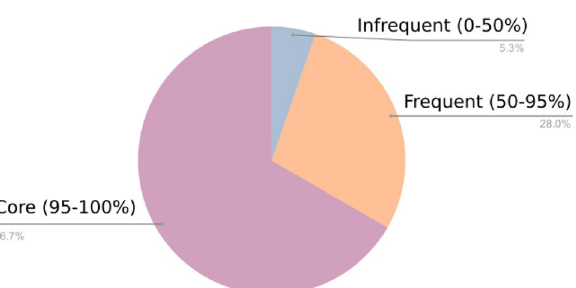
Figure 4. Positive selection and conservation. Frequency of the genes under positive selection across genomes. Most of the genes under positive selection belong to the core-genome.